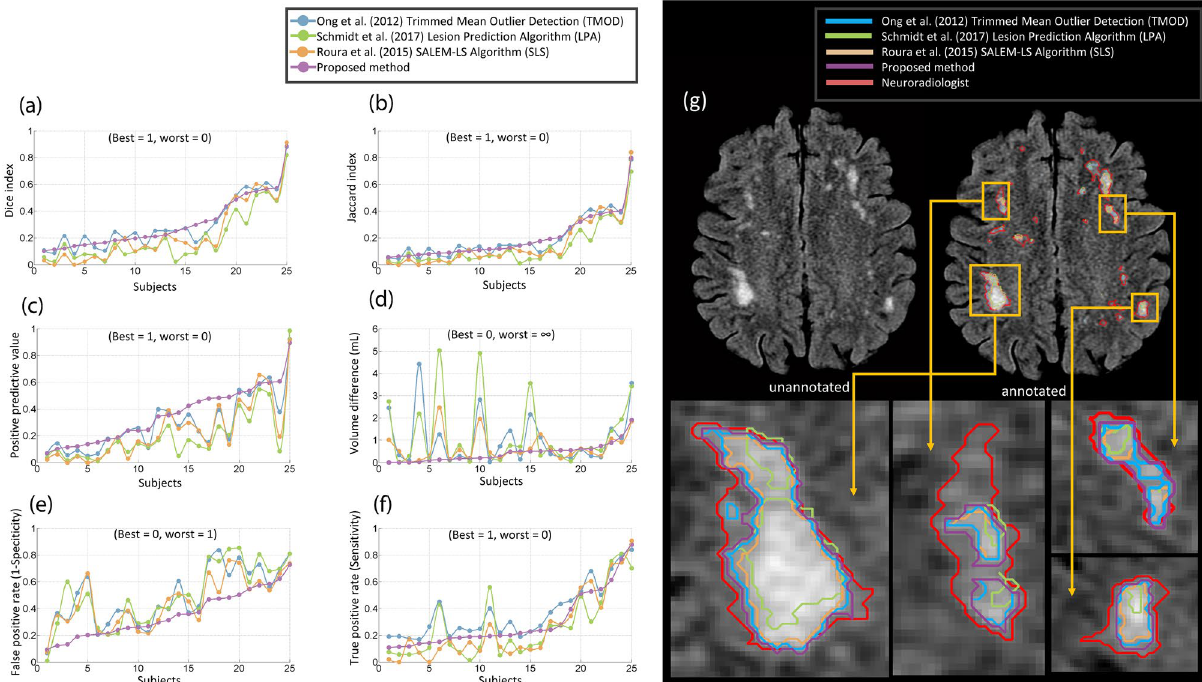
Figure 4. The performance of the proposed method compared to TMOD, LPA and SLS in well-established evaluation metrics. They are ( a ) Dice index, ( b ) Jaccard index, ( c ) positive predictive value, ( d ) volume difference, ( e ) false positive rate and ( f ) true positive rate. ( g ) The comparison of the proposed method and other comparative methods by qualitative analysis of WML